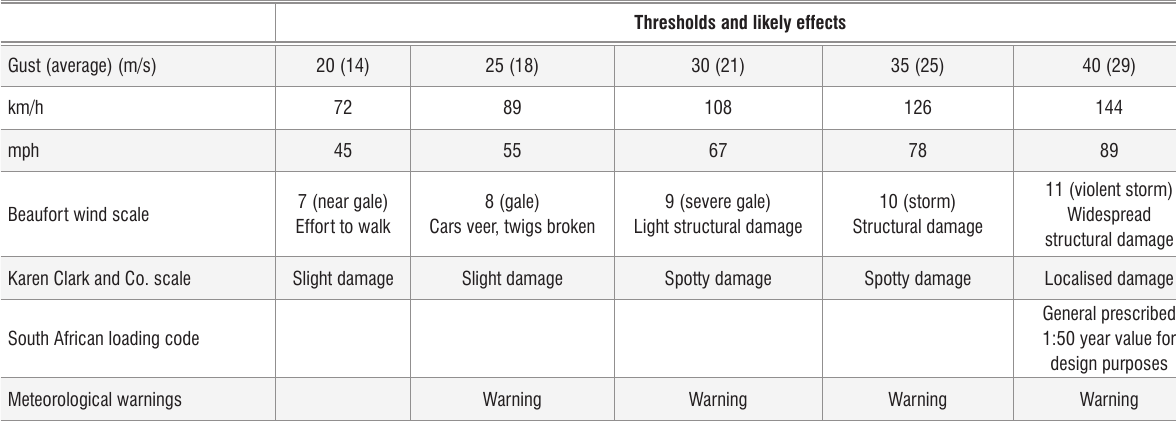
Wind thresholds, with indication of likely effects and damage to infrastructure